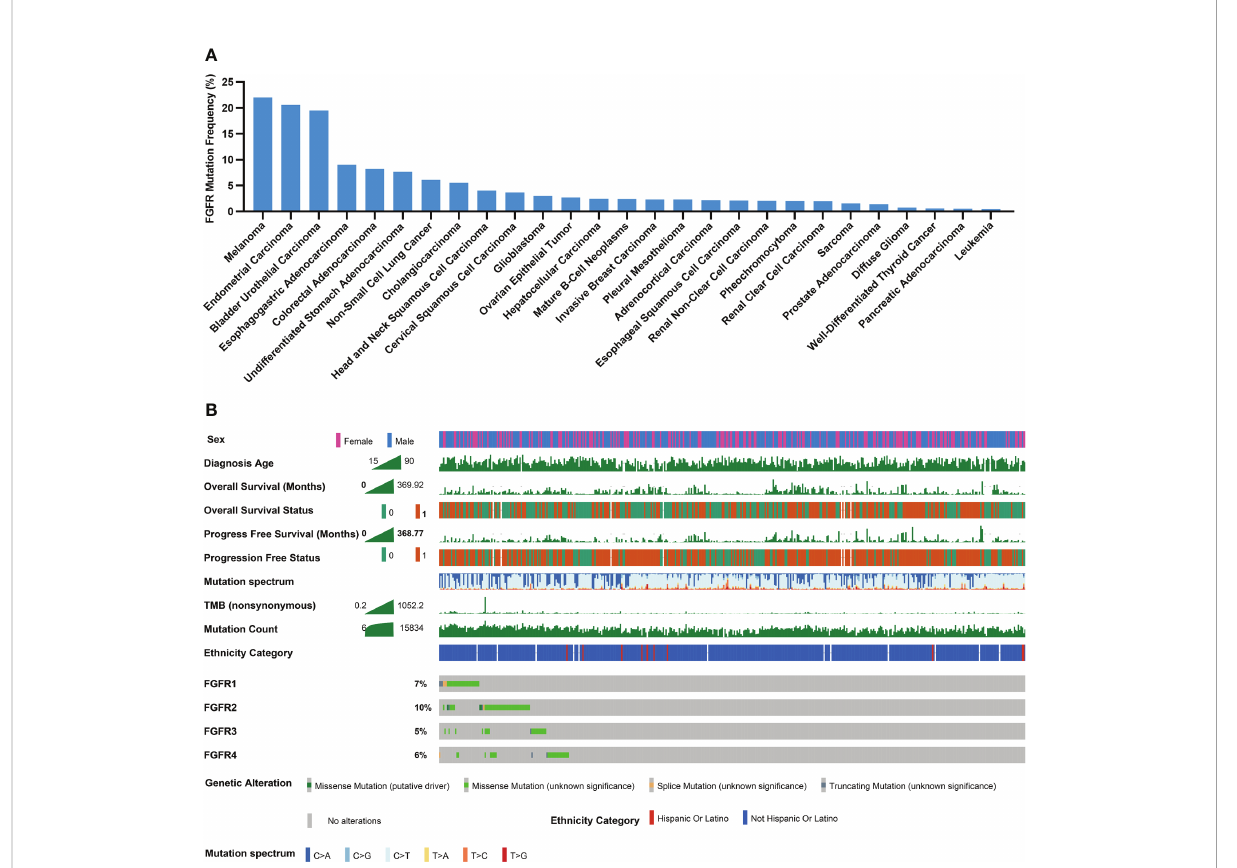
FIGURE 2 Mutational landscape of FGFR in melanoma cohorts. (A) The prevalence of FGFR mutations across 27 cancers. (B) Association of FGFR mutations and clinical characteristics in TCGA cohort (0 means no ending event occurred, 1 means ending event